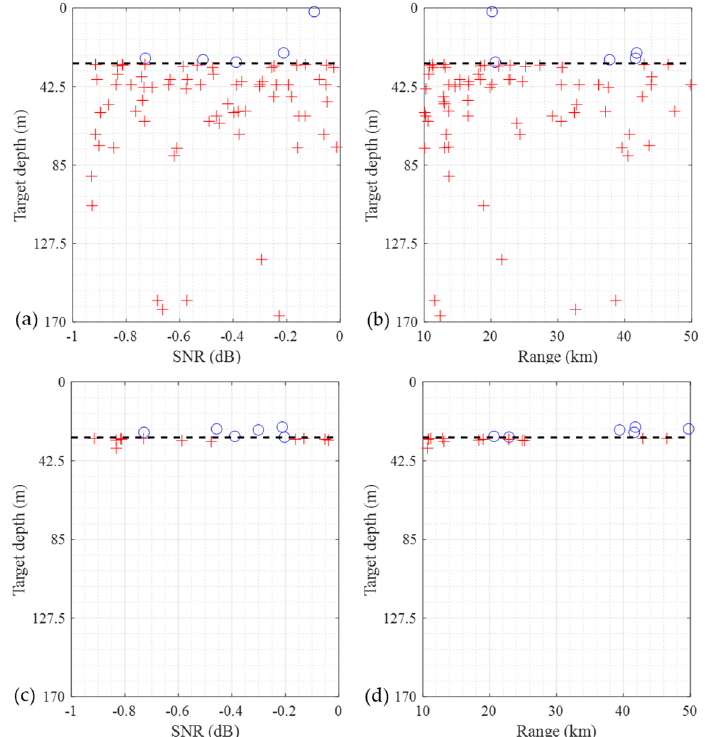
Figure 7. Scatter plots for the CNN misclassification using the absolute pCSDM (Figure 7a,b) and complex PCSDM (Figure 7c,d) in the TEST2 data as a function of the SNR or the range. The symbols ‘O’ and ‘+’ represent the misclassified positions of the underwater targets and surface targets, respectively.